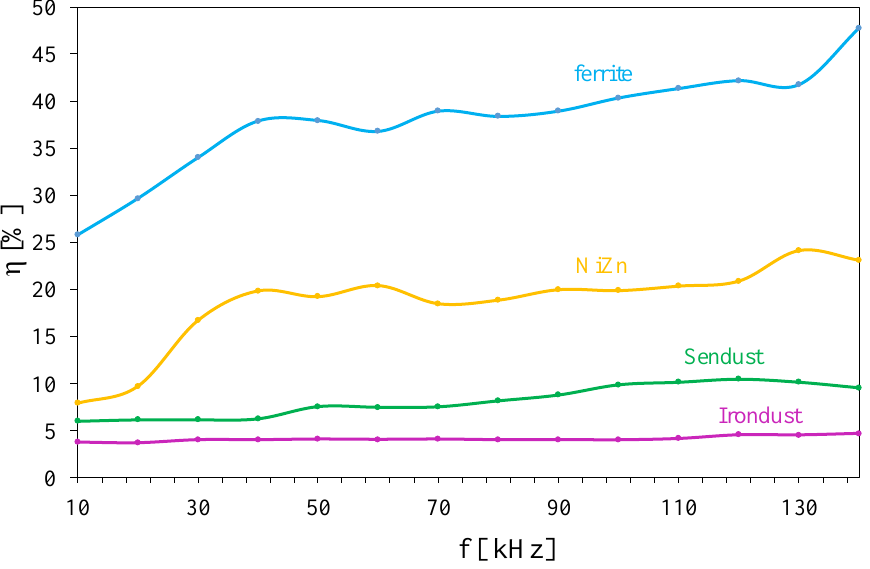
Figure 9. Dependence of the efficiency of energy transmission on the frequencies of various ferro- magnetic materials.